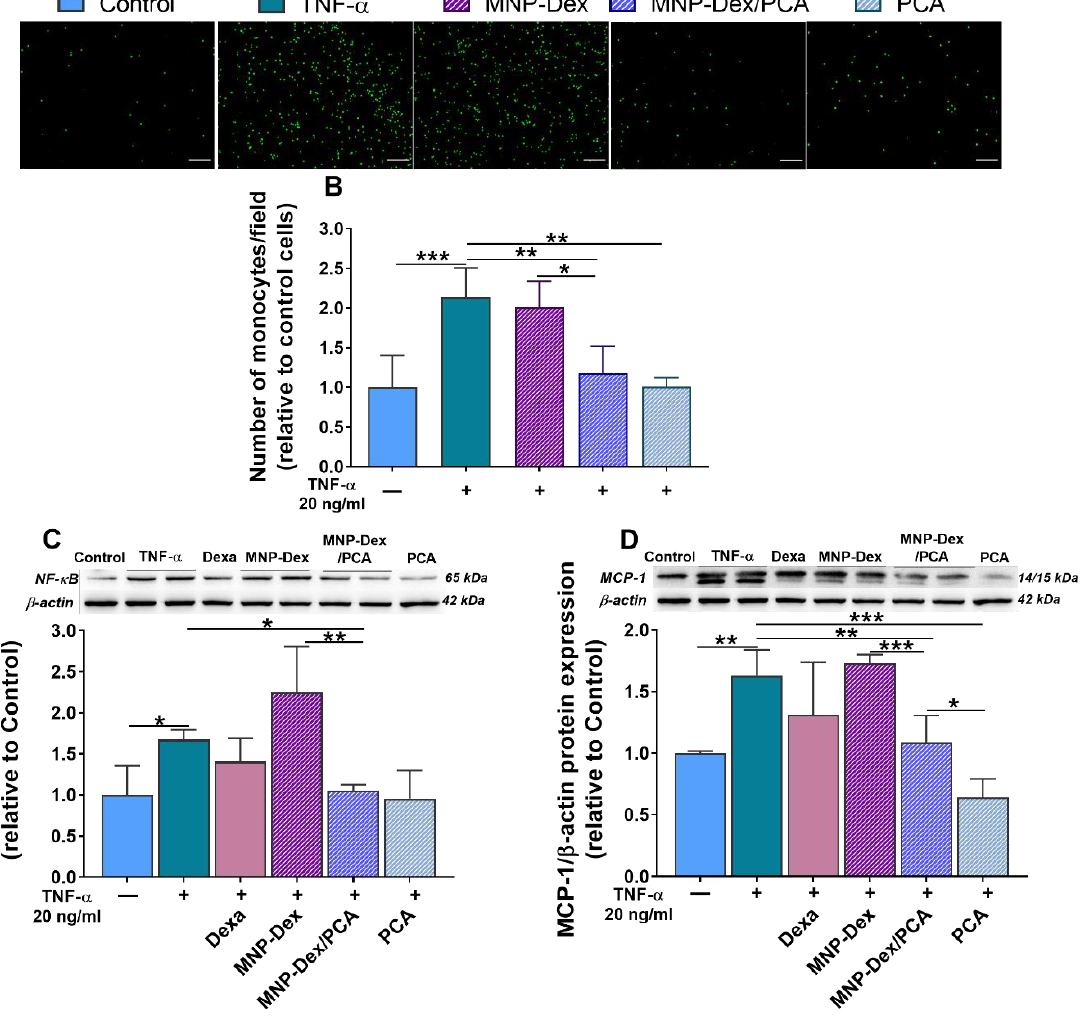
Figure 4. Anti-inflammatory effects of MNP-Dex/PCA on activated EC. Functional role of MNP-Dex/PCA in reducing THP-1 monocytes adhesion to TNF- α (20 ng/mL)-activated EC (+). Fluorescence microscopy images showing fluorescently labelled monocytes (green, ( A )) and quantification of adhered monocytes expressed as number/field ( B ). Protein expression of NF-kB p65 ( C ) and MCP-1 ( D ) in quiescent (-) and TNF- α activated EC (+) treated for 48 h with MNP-Dex/PCA, MNP-Dex, and free PCA at a pharmacologically relevant concentration of PCA (350 µ M). Dexa: treatment of EC with dexamethasone (2.5 µ M). Protein expression was normalized to β -actin. The data are expressed as mean ± SD from 3 independent experiments. * p < 0.05, ** p < 0.01, and *** p < 0.001.